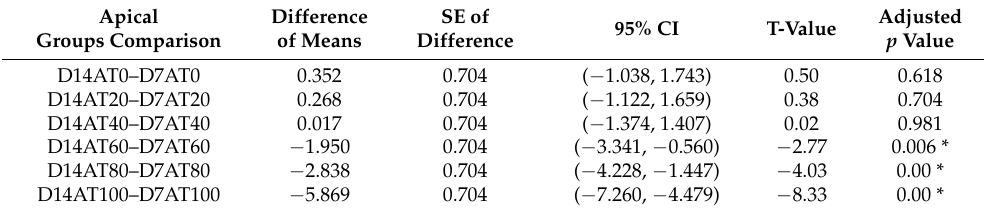
Table 6. Fisher test for 14 mm vs. 7 mm in the apical area. * p < 0.05. Apical Difference Groups Comparison of